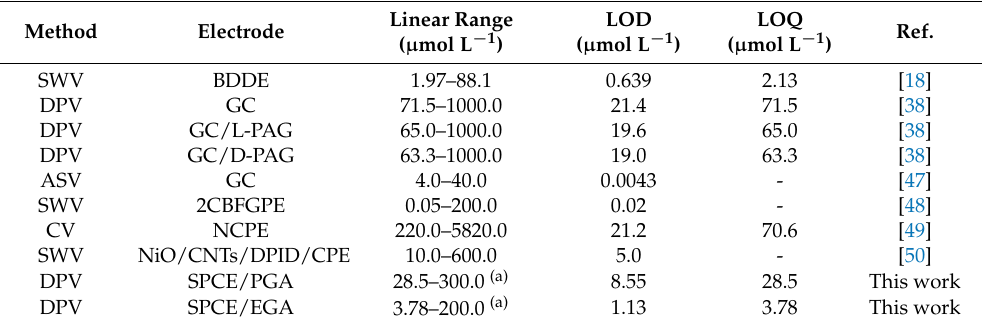
Table 2. Comparison of the analytical parameters of some electrodes used in the determination of